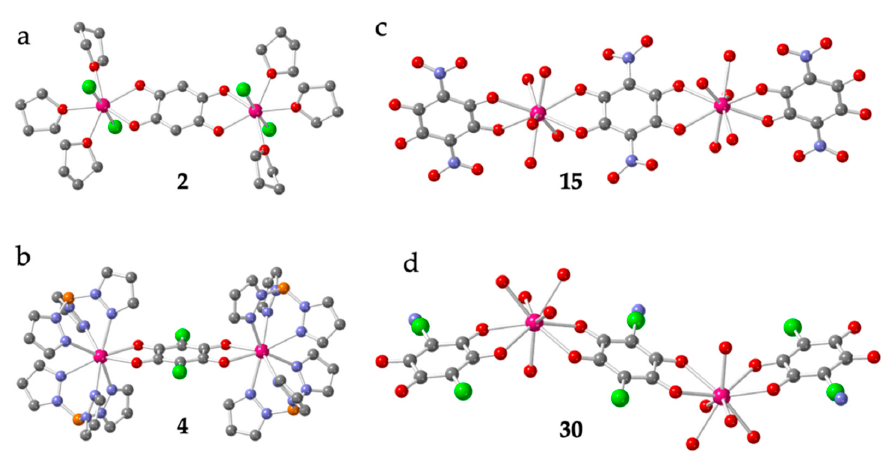
Figure 2. Structures of dimers 2 ( a ), 4 ( b ), 15 ( c ) and 30 ( d ) representative of the four types of Ln-anilato dimers. Colour code: Ln = pink, Cl = green, C = grey, O = red, B = orange and N = blue. (in 30, there is a positional disorder between the Cl and CN groups in the anilato ring).